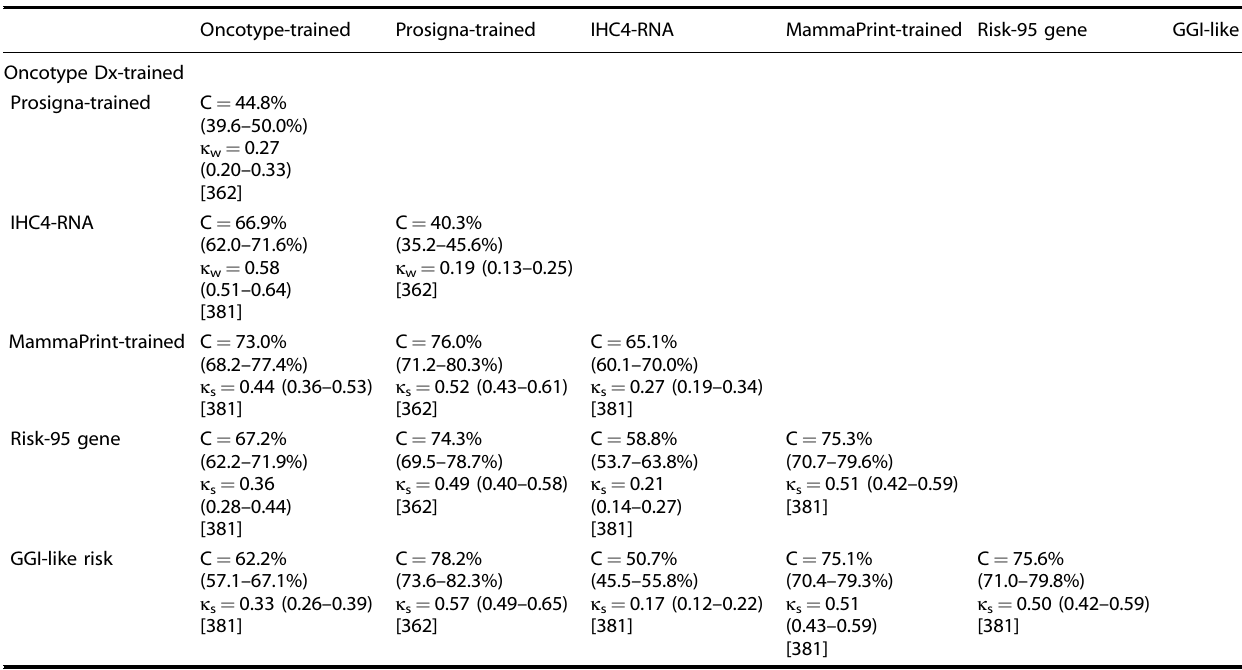
Table 2. Cross-tabulation of risk classi fi cation: low or low + intermediate vs